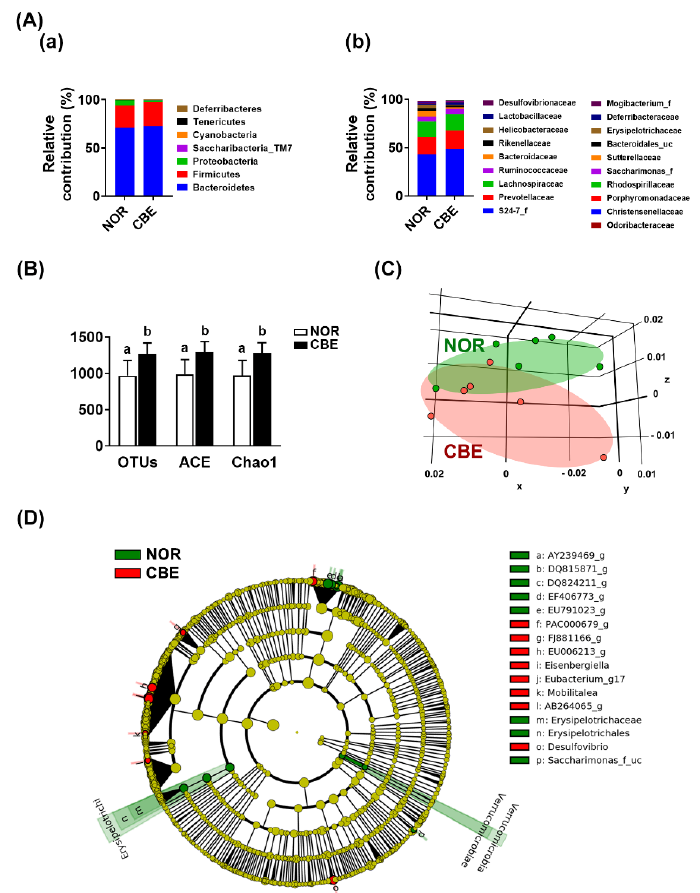
Figure 1. Effect of coffee bean extract (CBE) on the gut microbiota composition. ( A ) Effect on the gut microbiota composition. The relative composition at phylum ( a ) and family levels ( b ), assessed by pyrosequencing. ( B ) Effect on the α -diversity. ( C ) The principal coordinate analysis (PCoA) plot based on the pyrosequencing data. PCO1, principal component 1; PCO2, principal component 2. ( D ) Cladogram was generated via linear discriminant analysis effect size (LEfSE) analysis indicating significant differences in gut microbial abundances among normal control (NOR, green) and CBE- treated (CBE, red) groups. Data are shown as the mean ± S.D. ( n = 6). Means with same letters are not significantly different ( p <